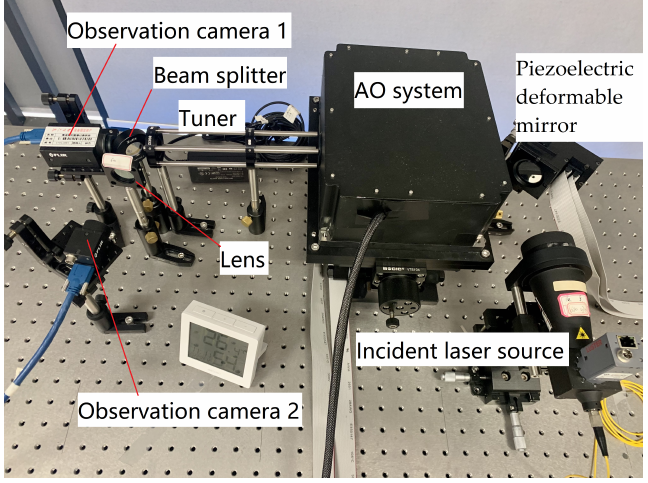
Figure 5. photograph of the